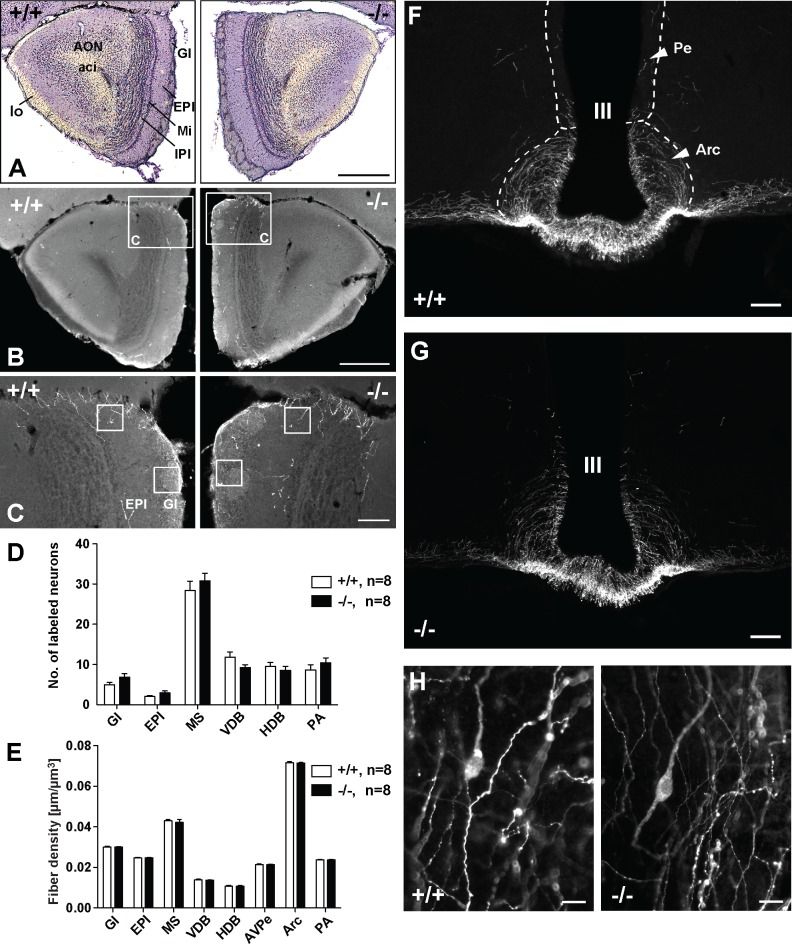
Organization of the olfactory bulb and hypothalamus in wt and Jacob-deficient mice.(A-C) Microphotographs showing the morphology of the olfactory bulb (BO) of wt (+/+) and Jacob/Nsmf ko (-/-) mice. (A) Nissl stained sections display the general morphology and subregions of the olfactory bulb (Bregma 2.8 mm, 50x magnification, scale bar 500 μm; Gl, stratum glomerulosum; EPl, stratum plexiforme externum, Mi, mitral cell layer, IPl, internal plexiform layer, AON, anterior olfactory nucleus, aci, anterior commissure, intrabulbar part, lo, lateral olfactory tract). (B) shows sections of both genotypes stained against GnRH (50x magnification, scale bar 500 μm). The frames in (B) indicate the image sections shown in (C). In (C) (200x magnification, scale bar 100 μm) the sample fields are marked, which were used to analyze the fiber densities in Gl and EPl. There are no differences in general morphology between wt and Jacob-deficient mice. (D, E) Quantification of GnRH-IR neurons (D) and fiber densities (E) in brains of wt (+/+) and Jacob/Nsmf ko (-/-) mice. (D) The number of GnRH-positive neurons was estimated in the olfactory bulb (Gl, EPl), in the medial septum (MS), ventral diagonal (VDB) and horizontal diagonal band (HDB) of Broca and preoptic area (PA). (E) The density of GnRH-IR fibers was analyzed in the same regions and furthermore in anteroventral paraventricular hypothalamic nucleus (AVPe) and nucleus arcuatus hypothalami (Arc). No significant differences were found between wt and Jacob/Nsmf ko mice (data are reported as mean ± SEM, two-way repeated measures ANOVAs were performed using REGION as within-subject factor and MOUSE LINE as between-subject factor. Post hoc analyses were performed using unpaired t-tests (Welch’s test) with Bonferroni-Holm adjustment). (F-H) Microphotographs showing the distribution of GnRH-IR neurons and fibers in the hypothalamic area of wt and Jacob/Nsmf ko mice. (F) and (G) display the periventricular (Pe) and arcuate hypothalamic nuclei (Arc) around the third ventricle (III) (Bregma -1.70 mm, scale bars are 100 μm). (H) shows exemplary GnRH-IR neurons in the medial preoptic area (PA) of wt and Jacob/Nsmf ko mice (Bregma 0.5 mm, scale bars are 20 μm).